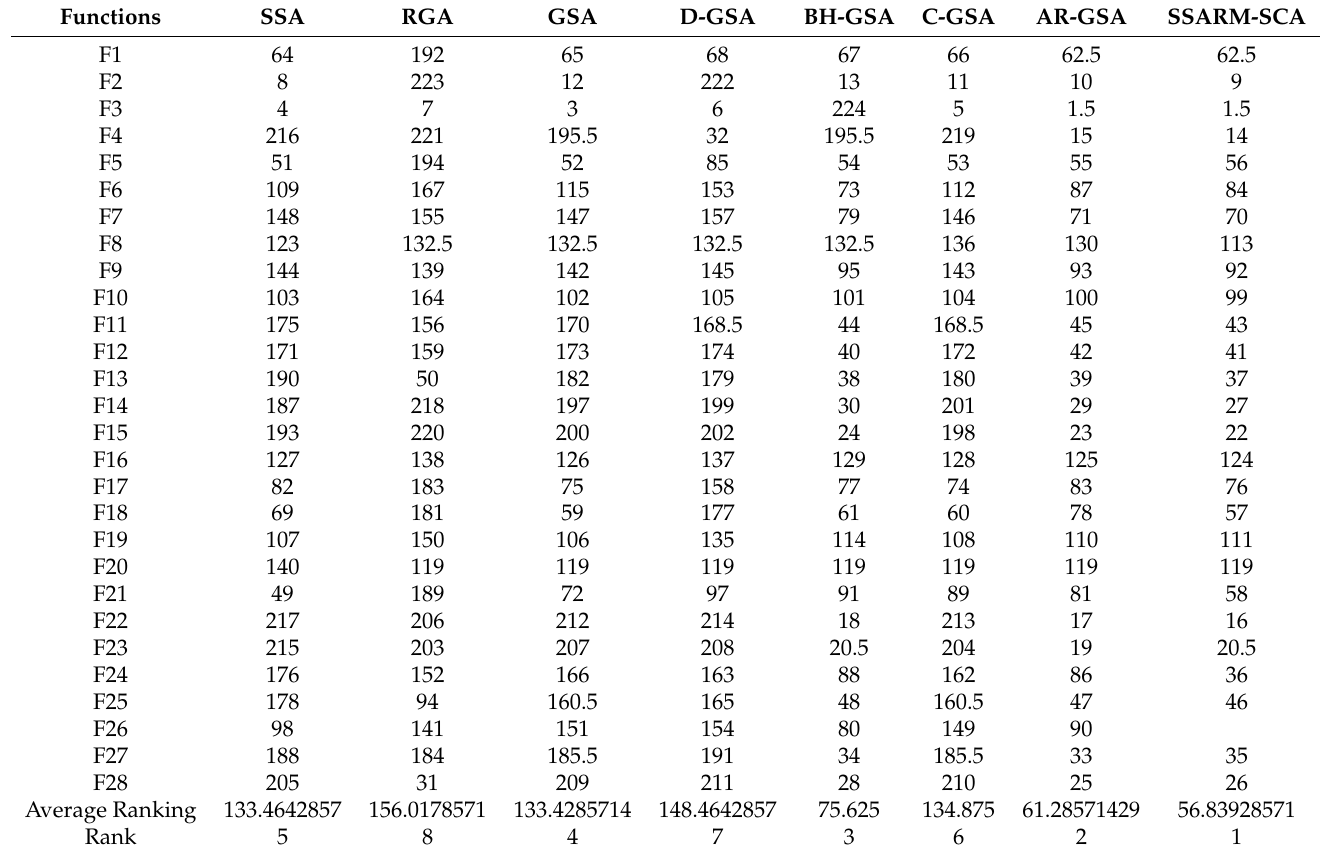
Table 6. Aligned Friedman test ranks for the compared algorithms over 28 CEC2013 functions.